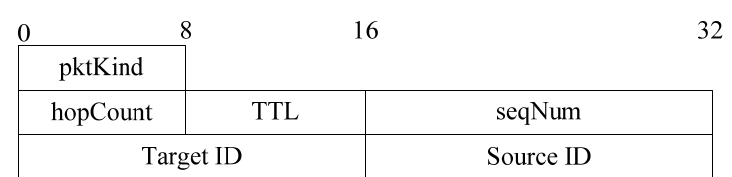
Figure 13. Format of query